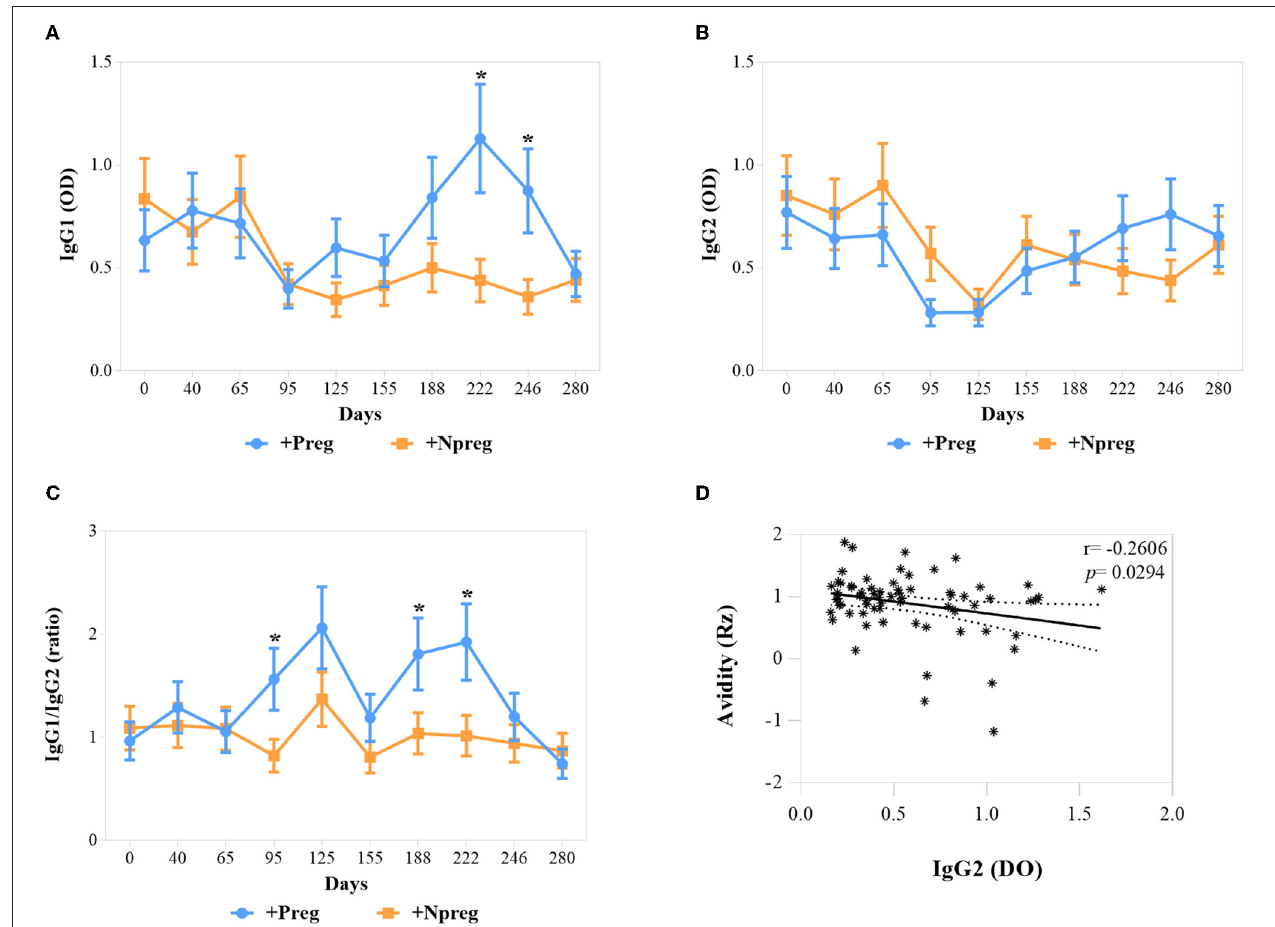
FIGURE 3 | Optical densities (OD) of IgG1 (A) , IgG2 (B) , and IgG1/IgG2 ratio (C) in Neospora caninum seropositive cows. Each point represents the mean ± standard error of the mean (SEM) at the different sampling times for groups + Preg and + Npreg. Correlation between Avidity (Rz) and IgG2 (D) . The significant statistical differences between groups were analyzed: * p <